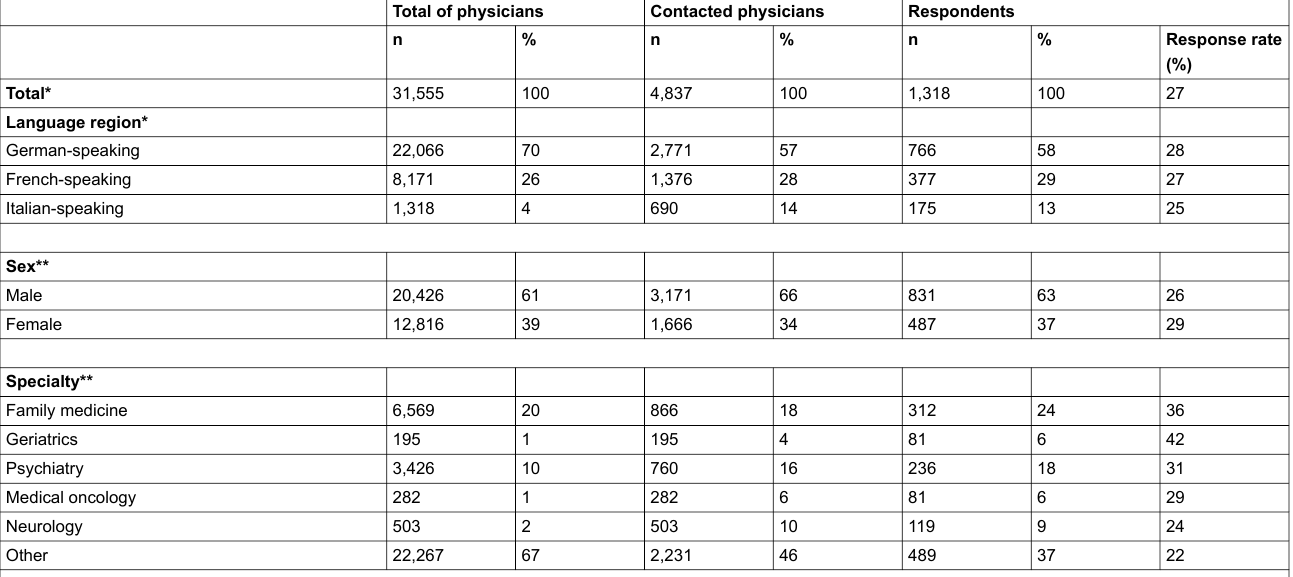
Table 1: Total of physicians in Switzerland, contacted physicians, and respondents of the questionnaire. Total of